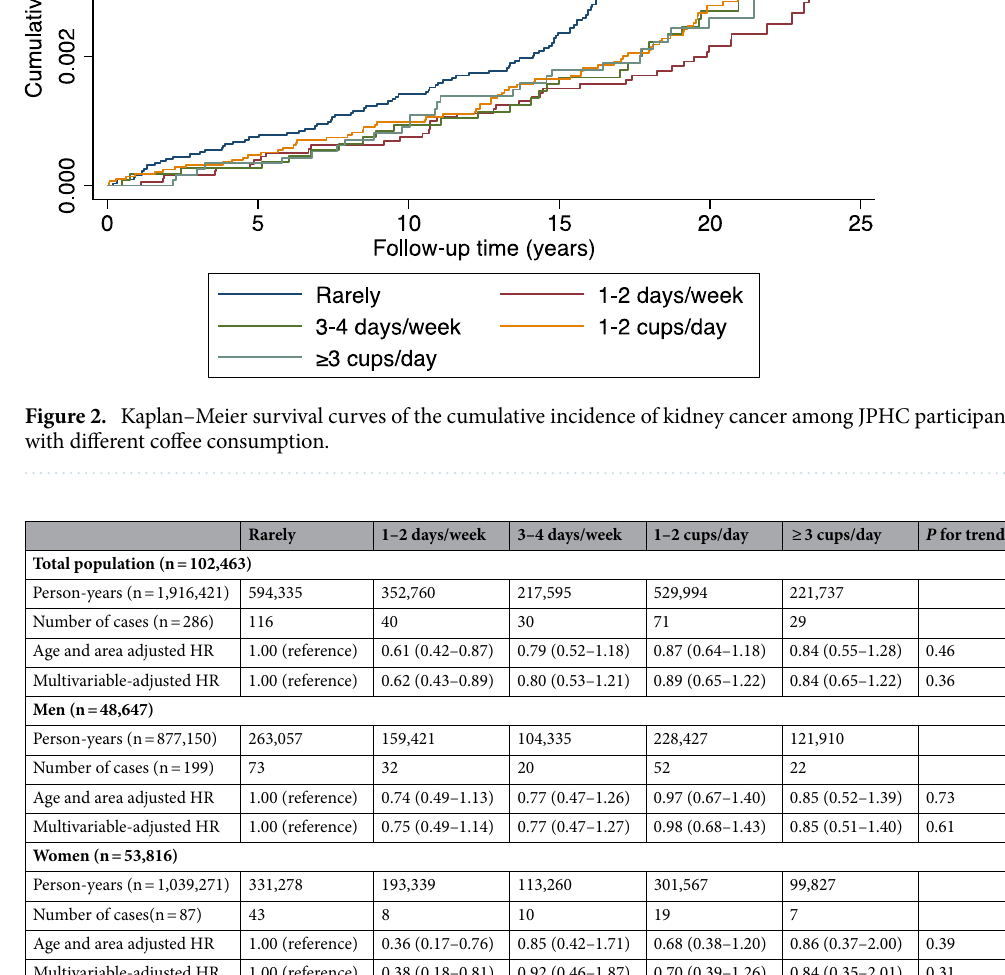
Table 4. Hazard ratio and 95% confidence interval for kidney cancer incidence according to coffee consumption in Japanese adults. a In multivariable-adjusted models for men and women, adjusted variables included age (stratified by age groups: 45–49, 50–54, 55–59, 60–64, 65–69 and > 70 years old), sex (men and women), PHC area (stratified by 10 areas), smoking (past, current, never, missing), history of hypertension (yes, no, missing), history of diabetes (yes, no, missing), history of renal diseases (yes, no, missing), drinking frequency (rarely, 1–3 days/month, 1–2 days/week, 3–4 days/week, ≥ 5 days/week, missing), body mass index (< 18, 19–22, 23–25, 26–29, > 30, missing), physical activity (rarely, 1–3 days/month, 1–2 days/week, 3–4 days/ week, almost daily, missing). Models were mutually controlled coffee consumption. In the models for the total population, in addition to these variables, sex was also